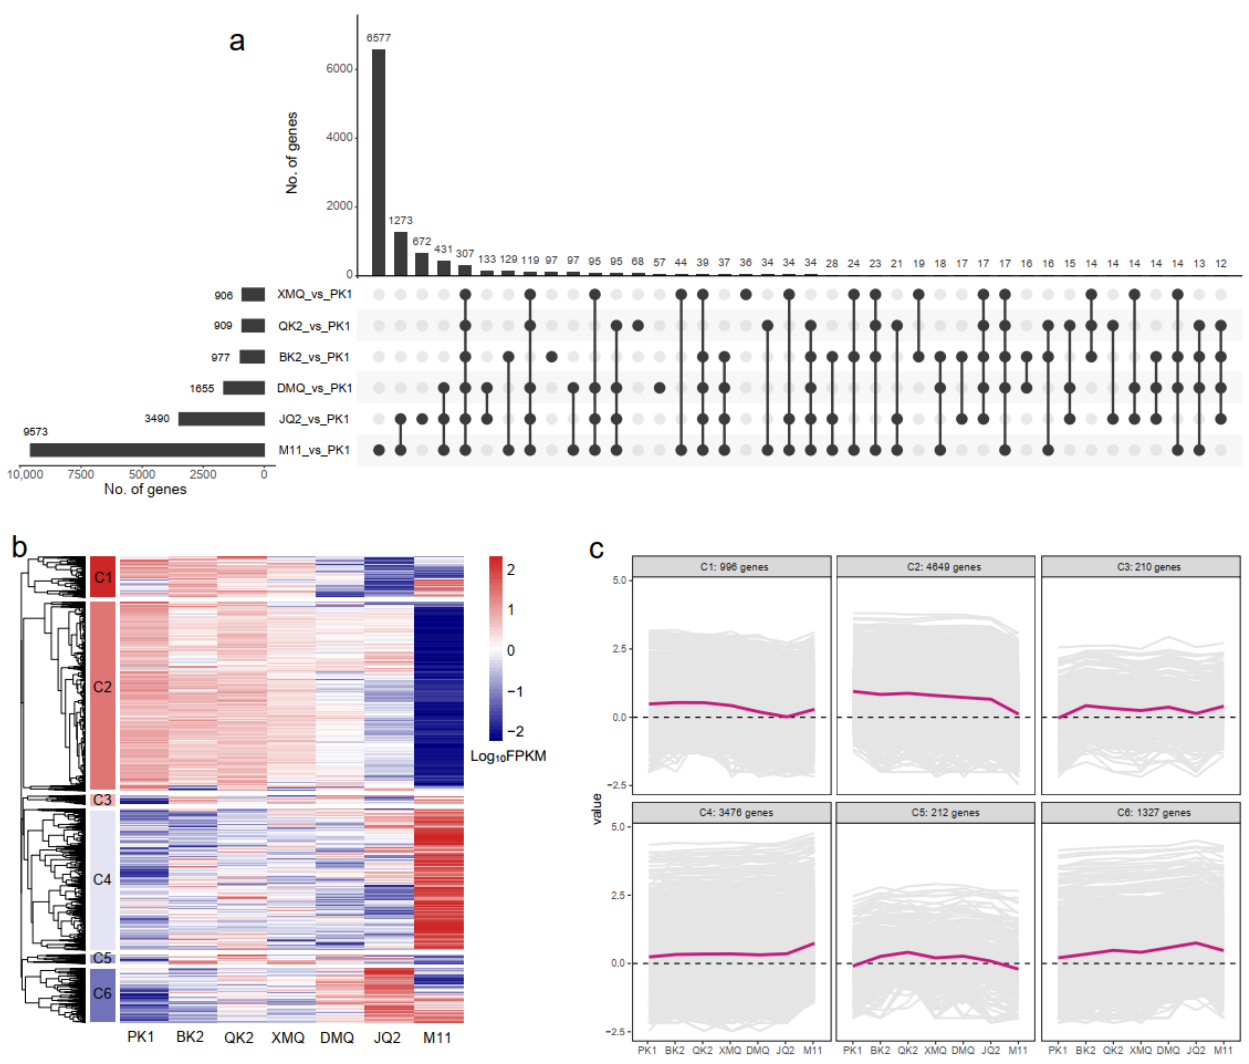
Figure 2. Analyses of differentially expressed genes (DEGs) in seven Tartary buckwheat varieties. ( a ) Upset plot of the DEGs in six comparisons. Black bars on the lower left represent the number of DEGs in comparisons of seven selected varieties. The black dots on the lower right represent the common DEGs existing in six comparisons. Black bars above represent the number of common DEGs in six comparisons; ( b ) Functional category of DEGs by hierarchical cluster; ( c ) Gene expression patterns of the six clusters that correspond to the hierarchical cluster result. Six main clusters were presented as C1–C6. Gene expression values are normalized to log 10